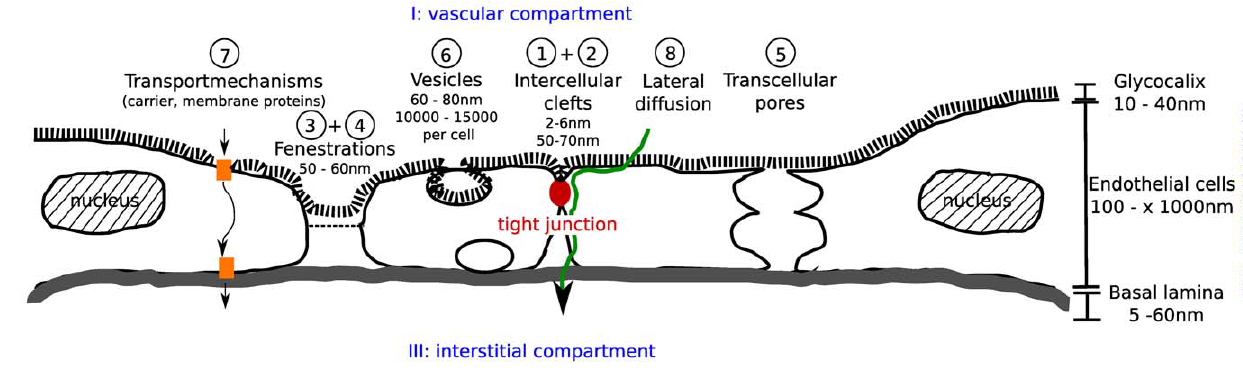
Figure 7. Paracellular and transcellular pathways [ 48 ] .